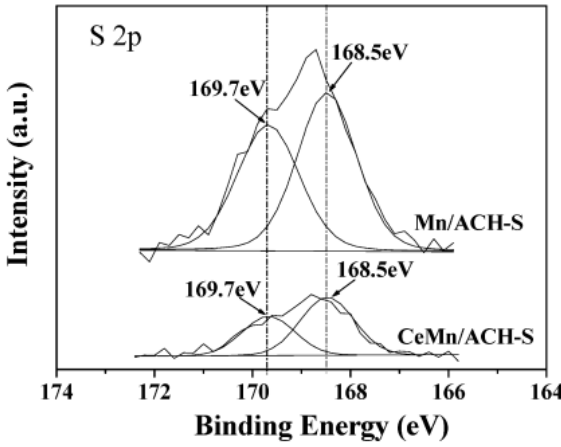
Figure 27. SO 2 + H 2 O tolerance test at 180 °C (Reaction conditions: [NH 3 ] = [NO] = 500 ppm, [O 2 ] =7 vol %, [SO 2 ] = 200 ppm, [H 2 O] = 10 vol % (when used), N 2 as balance gas, GHSV=67,000 h − 1 ). (Reproduced with permission from Reference [51], Copyright 2015, Elsevier.).